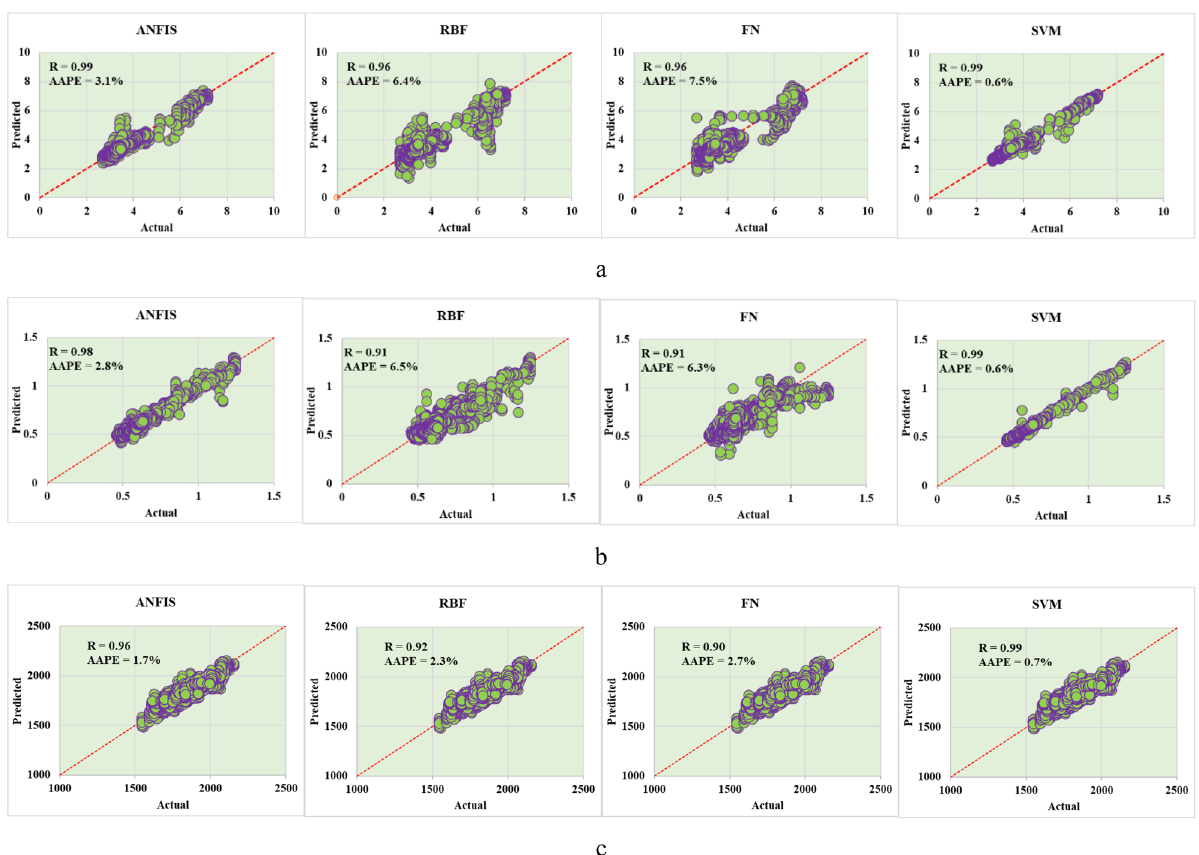
Figure 5. Training results for the developed vibration models ( a ) lateral ( b ) axial ( c )